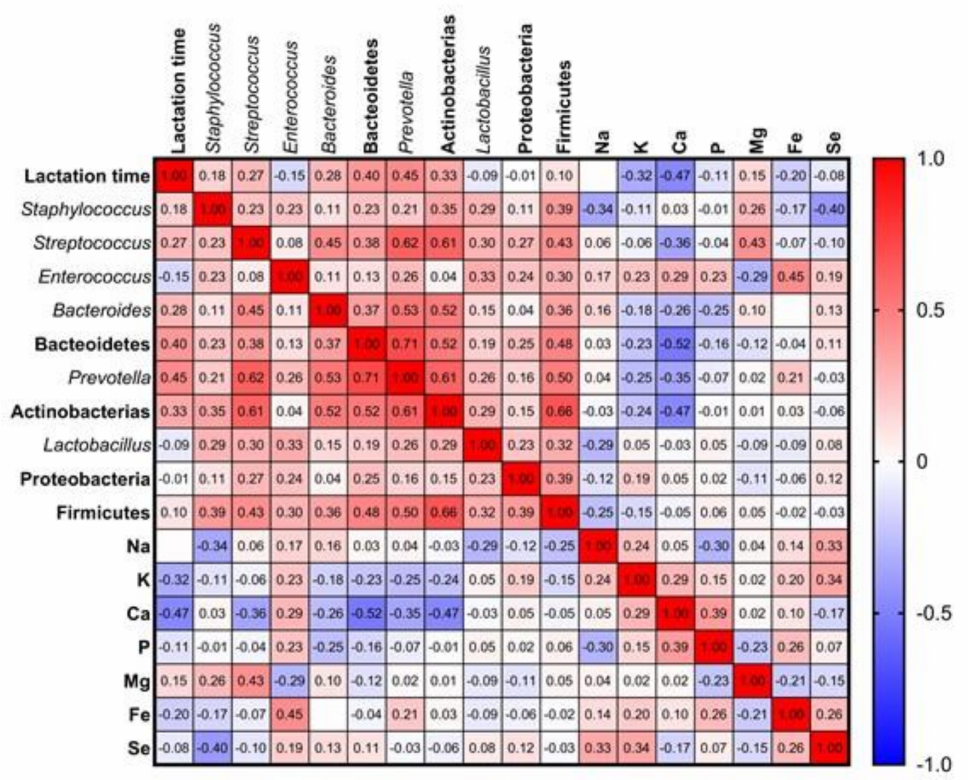
Figure 4. Graphical Spearman correlation matrix showing pairwise correlations between breast milk minerals and microbiota groups in healthy Spanish mothers; colours are added for better visualization of correlation r